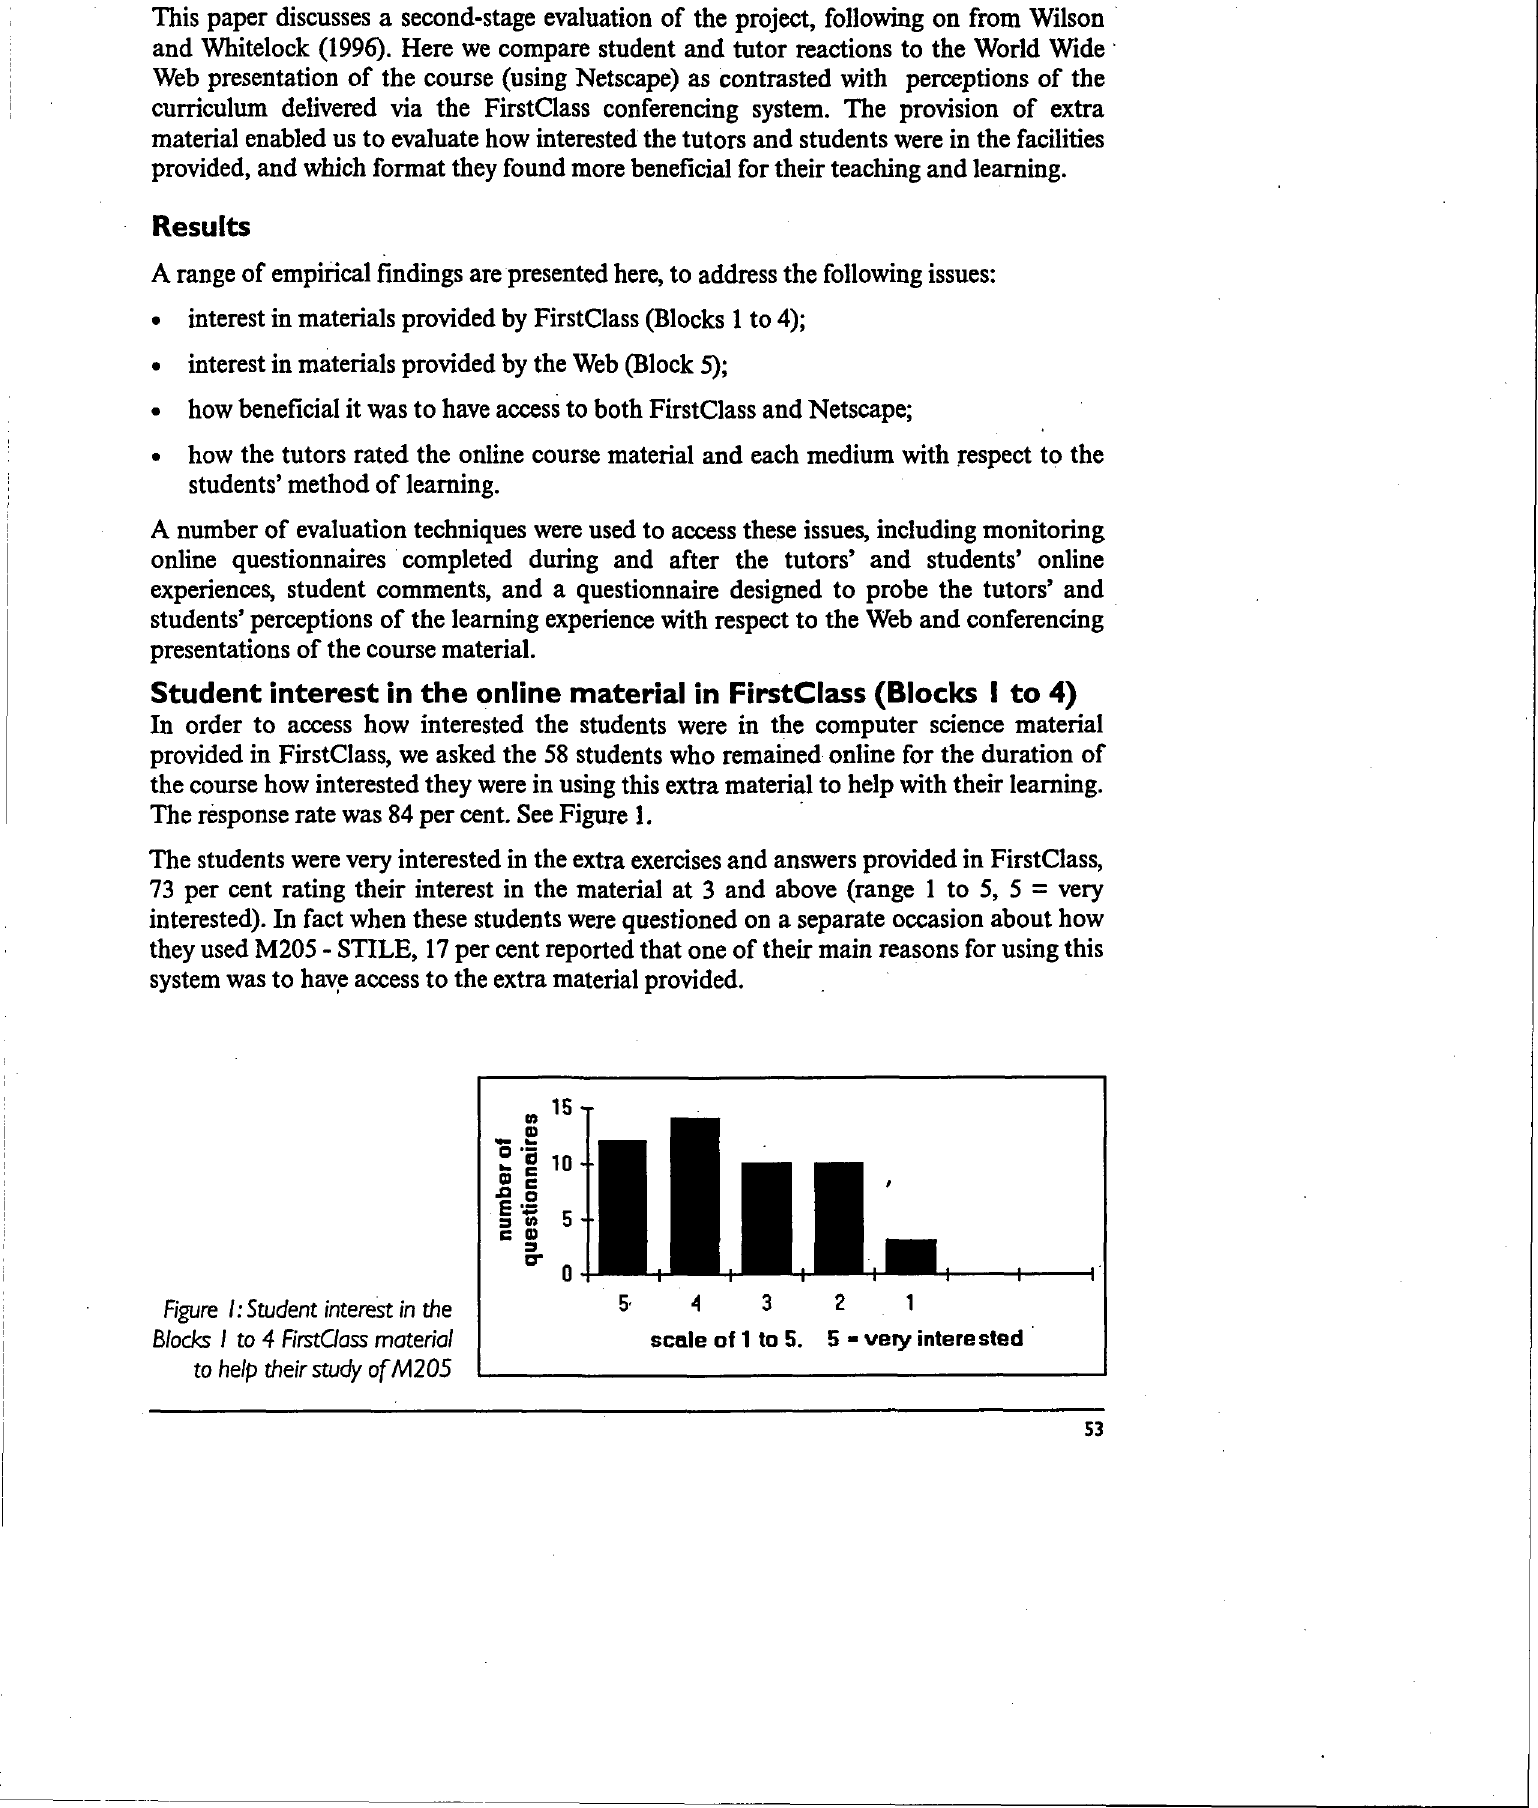
figure I: Student interest in the Blocks I to 4 FirstClass